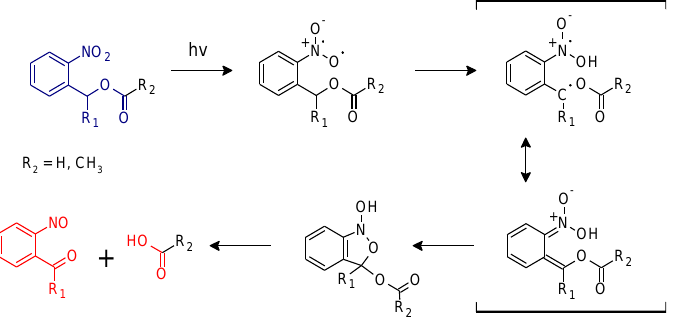
Figure 1. Photoreactions of ortho-nitro benzyl esters (Reproduced by [21] published by the Royal Society of Chemistry) .